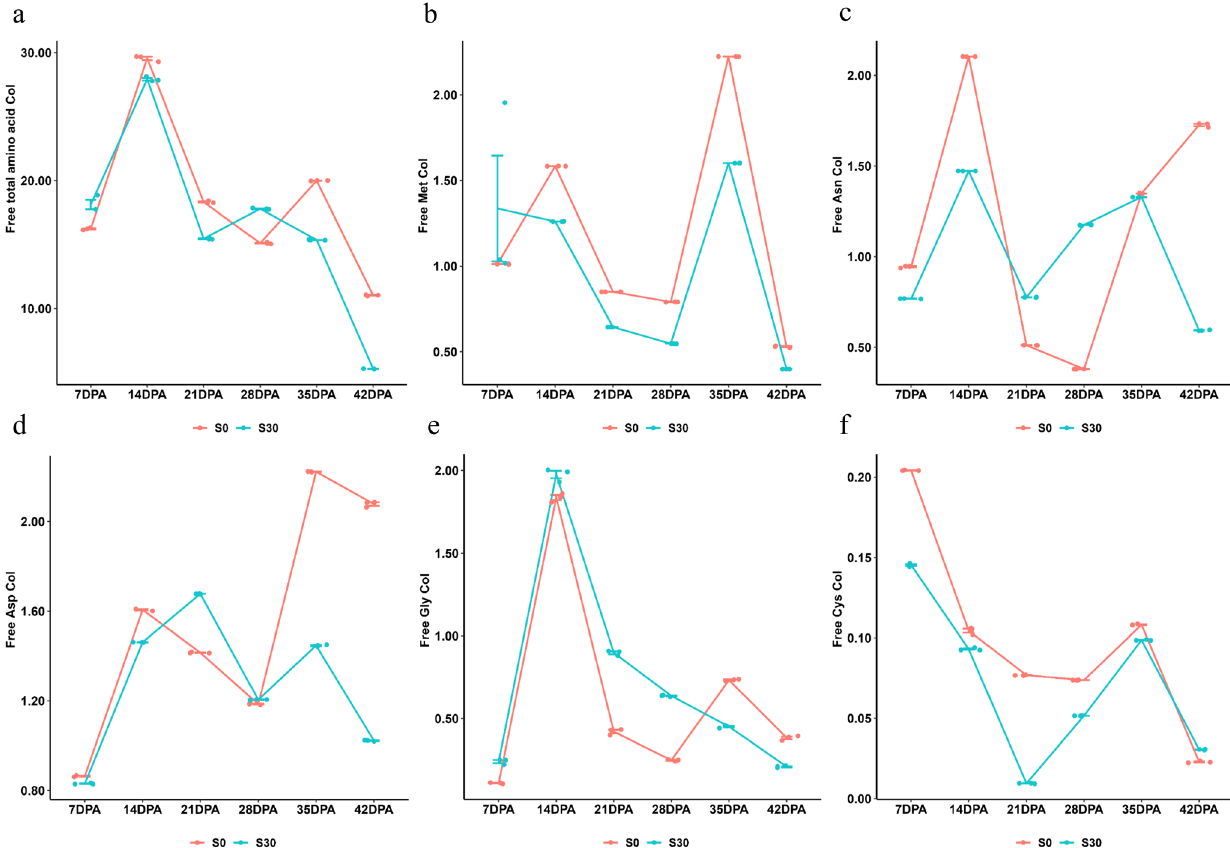
Fig. 5 Comparison of six free amino acid dynamics between different sulfur treatments across six grain- fi lling stages in 2015 glasshouse experiment. Detailed information is shown in the Supplementary Note 1. For all panels, the S0 (red) and S30 (green) mean 0 and 30 kg ha − 1 sulfur treatments, respectively; DPA days post-anthesis, CoI content index (free amino acid% × 10 4 ). The developing grain samples of three replicate pots from the same grain developing stage and sulfur treatment were pooled together, making it 12 pooled developing grain samples with three technical repeats each; line graph shows the means ± 3 technical repeats with a mix of three biologically independent replicates (or three pots); the dots with red and green show the data distribution of Spit fi re under S0 and S30, respectively. a The comparison of the dynamics of free total amino acid CoI between S0 and S30 treatments during grain- fi lling. b The comparison of the dynamics of free methionine (Met) CoI between S0 and S30 treatments during grain- fi lling. c The comparison of the dynamics of free asparagine (Asn) CoI between S0 and S30 treatments during grain- fi lling. d The comparison of the dynamics of free aspartic acid (Asp) CoI between S0 and S30 treatments during grain- fi lling. e The comparison of the dynamics of free glycine (Gly) CoI between S0 and S30 treatments during grain- fi lling. f The comparison of the dynamics of free cysteine (Cys) CoI between S0 and S30 treatments during grain- fi